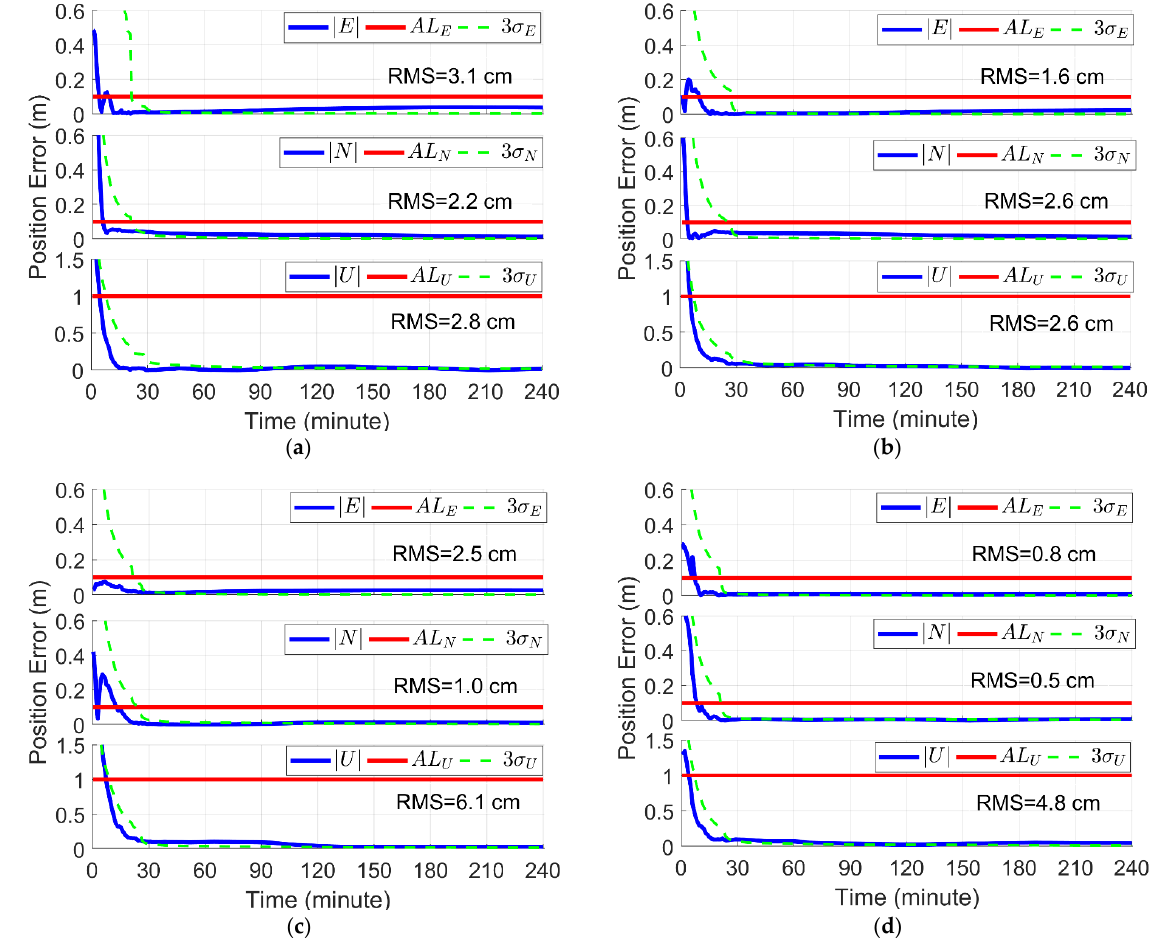
Figure 9. The three PEs, including the updated STDs and ALs of the: ( a ) BREW station; ( b ) FAIR station; ( c ) HUEG station; and ( d ) DAV1 station. The top, middle and bottom panels of each figure represent the east (E), north (N) and up (U) directions. The RMSs of the PEs after convergence are noted on the panel, respectively.